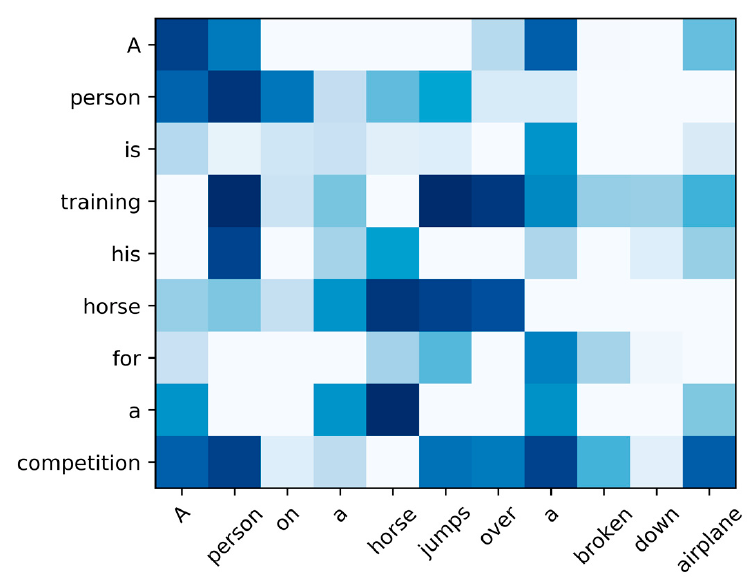
Figure 4. Visual results of sentence to semantic correlation analysis.